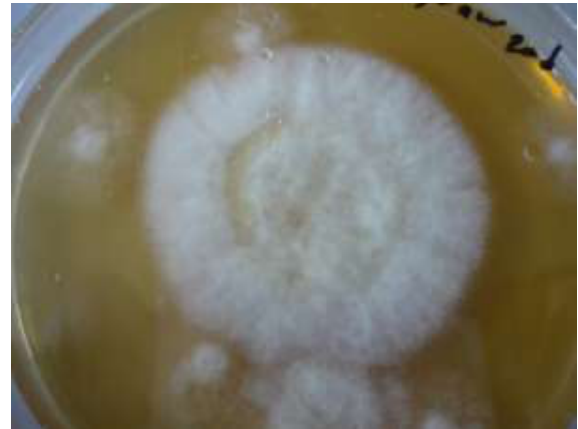
Figure 3: Culturing of Branchiomyces spp. on the Sabouraud's dextrose agar after three days from Cyprinus carpio.